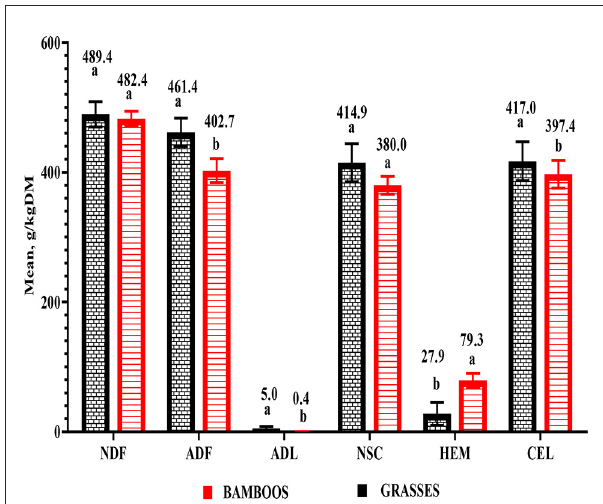
FIGURE2 Average detergent fiber pools for the leaf biomasses of bamboo ( Bambusa balcooa (Beema), Oxytenanthera abyssinica (A. Rich.) Munro and Bambusa vulgaris) and grass ( Cenchrus purpureus, Megathyrsus maximus, and Brachiaria decumbens ). Data points are mean of means ( n = 3) ± SEM. Data bars with similar superscripts (a, b ) are not significantly different (p > 0.05); NDF, neutral detergent fiber; ADF, acid detergent fiber; ADL, acid detergent lignin; NSC, non-structural carbohydrate; HEM, hemicellulose; CEL, cellulose.